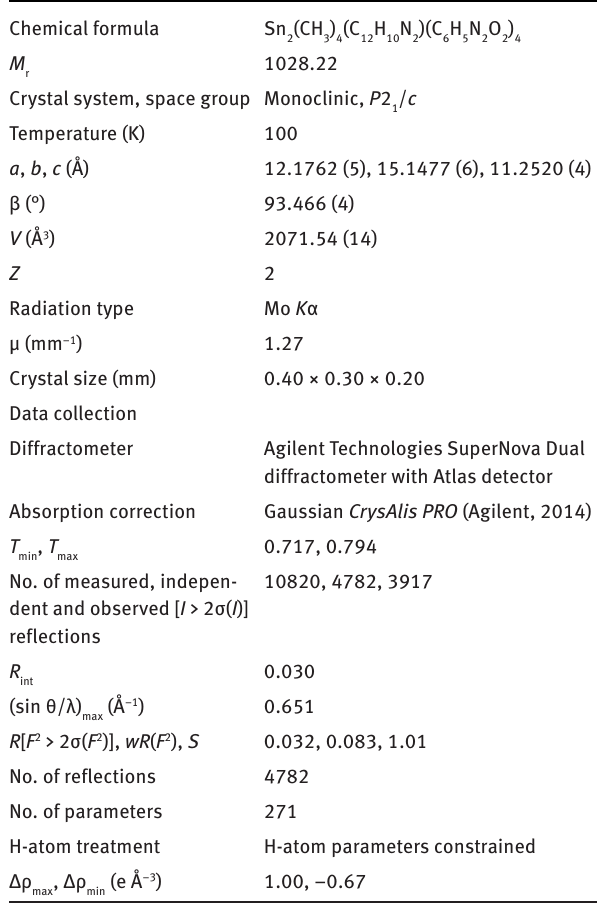
Table 1: Crystal data, data collection and structure refinement details of complex